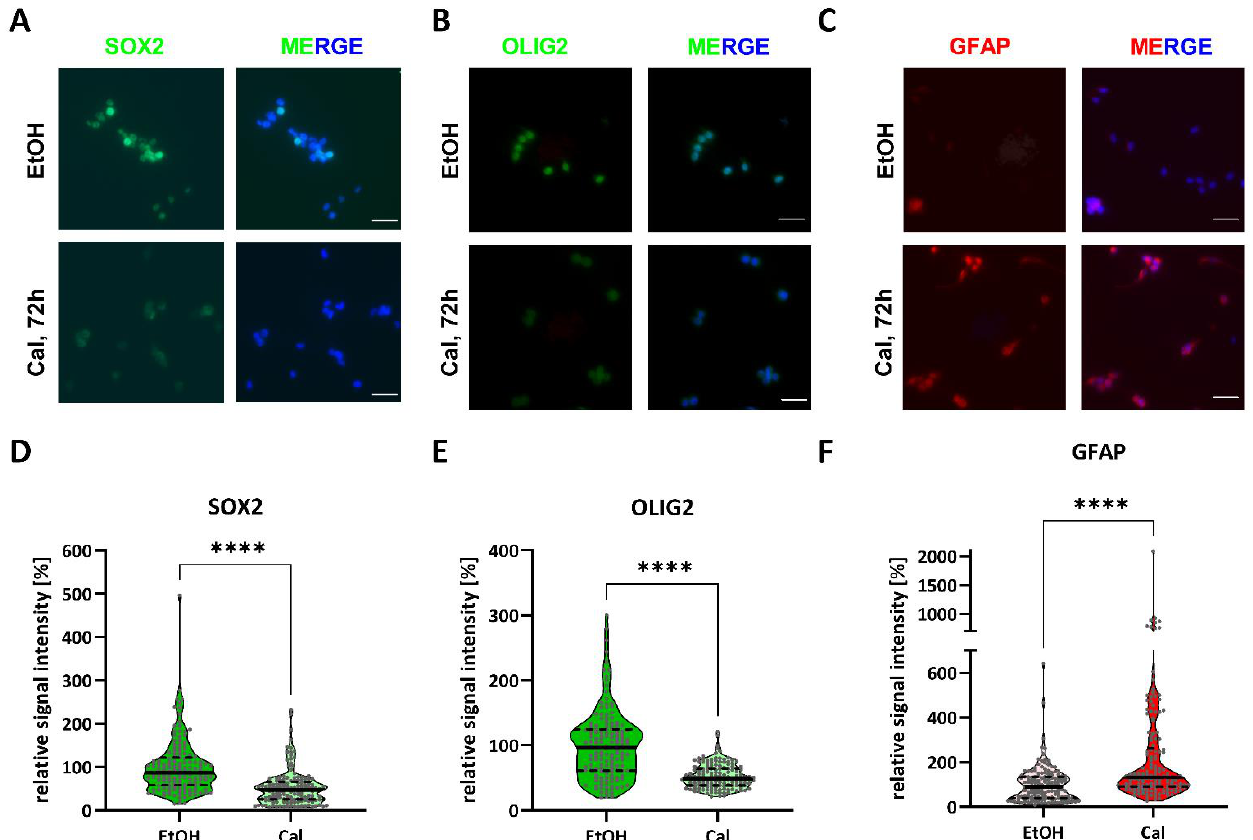
Figure 6. Calcitriol reduces SOX2 and OLIG2 stemness marker expression and increases GFAP differentiation marker expression: ( A – C ) representative immunofluorescence pictures of NCH644 GSCs 72 h after treatment with 50 nM of calcitriol (Cal) or solvent (EtOH) and ( D – F ) violin plots of the quantification of 50 cells from at least three random vision fields taken at 20 × magnification of three independent experiments after staining against ( A , D ) SOX2, ( B , E ) OLIG2 and ( C , F ) GFAP. The solid horizontal line marks the median and the dashed lines separate the quartiles. **** p < 0.0001; two-tailed t -test. Scale bar: 50 µm.